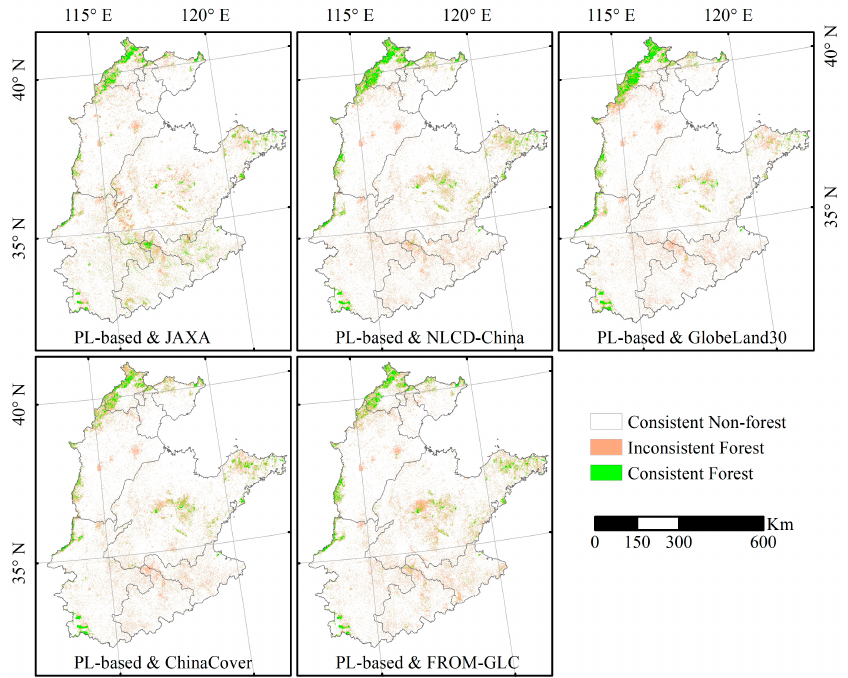
Figure 9. Spatial comparison between the PL-based and other forest maps.